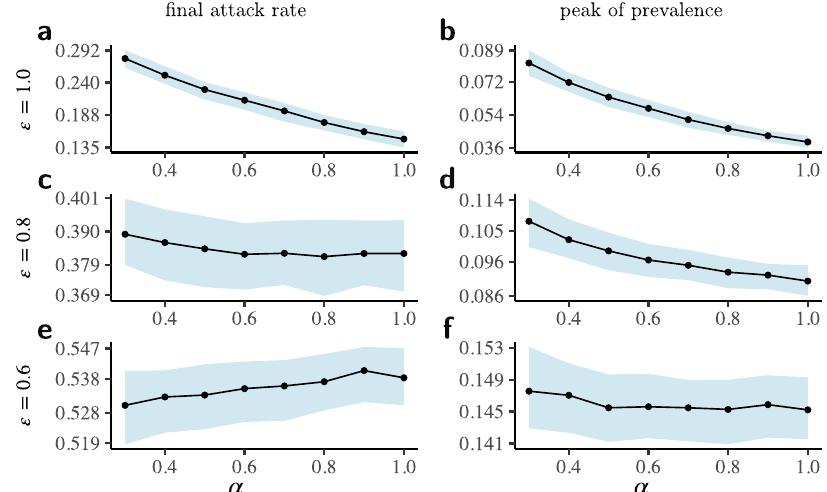
Fig. 5 The three dynamical regimes con fi rmed for a real-world temporal contact network. Final attack rate and peak of prevalence, respectively, for vaccine ef fi cacy, ε = 1.0 ( a , b ), ε = 0.8 ( c , d ), and ε = 0.6 ( e , f ) as functions of the mixing parameter, α , resulting from the numerical simulations performed on top of a real-world temporal contact network from the Copenhagen Networks Study 40 . This consists of N = 672 nodes and 374,884 edges (pairwise interactions) spread over 8064 timestamps, binning 4 weeks of recording time into 5-min intervals. Dots indicate the median value, whereas the shaded area indicates fi rst and third quartiles. Each point is obtained by averaging over 2 × 10 4 runs. We fi xed the vaccine coverage to V = 0.5, the recovery rate to μ = 4.6 × 10 − 4 (corresponding to a mean infection time of 7.5 days) and the transmission probability to β = 1.142 × 10 − 1 , yielding R estimation R 0 = βκ / μ , where κ ¼ s 2 = (cid:2) s , being (cid:2) s ( s 2 ) the network average of the (squared) number of contacts per